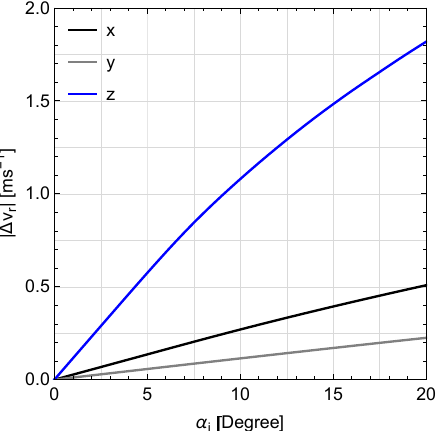
Figure 6. Mean absolute difference | Δ 𝑣 𝑟 | between the radial speeds generated by a wind turbine blade as measured by a SpinnerLidar configuration with no misalignment and one with a misalignment angle within 0 ◦ and 20 ◦ around the 𝑥 -axis, 𝑦 -axis, and 𝑧